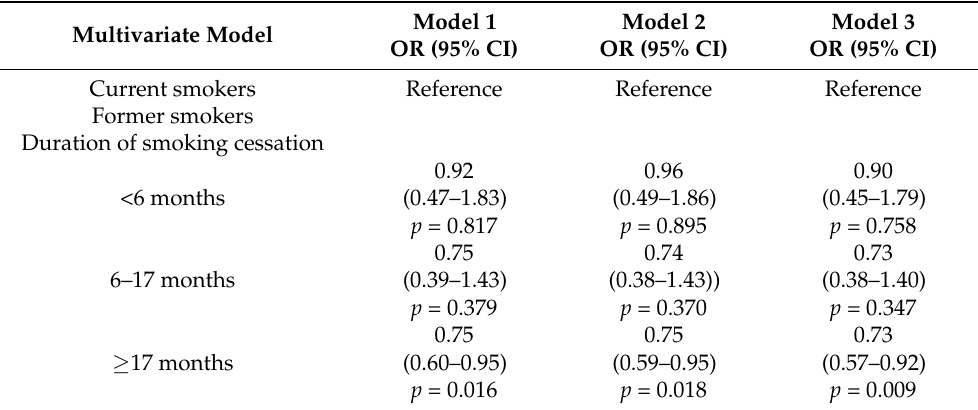
Table 2. Unadjusted and adjusted odds ratios and 95% confidence intervals for the elevated serum hs-CRP level * according to duration of smoking cessation in Korean